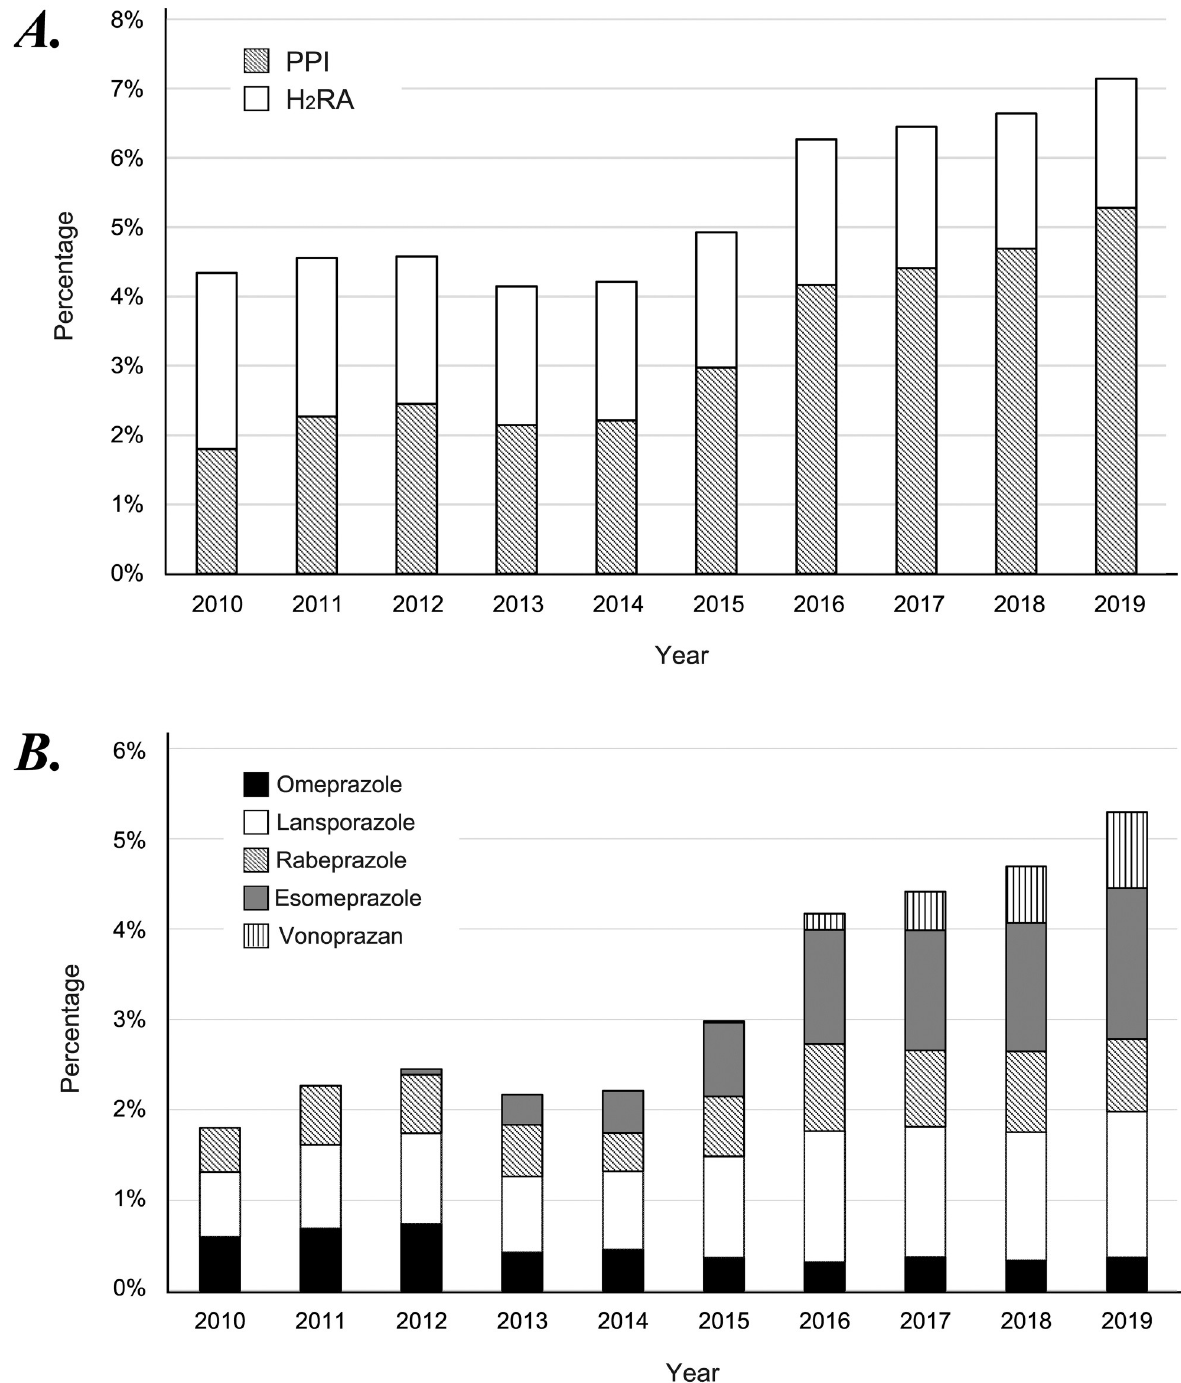
Fig 1. Trend in PPI and H 2 RA uses from 2010 to 2019 in Japan. (a) Changes in the percentages of PPI and H 2 RA users from 2010 to 2019 based on the data of generally healthy individuals in Japan. (b) Changes in the rate of the use of five types of PPI from 2010 to 2019 in Japan. PPI, proton pump inhibitor; H 2 RA, histamine H 2 receptor